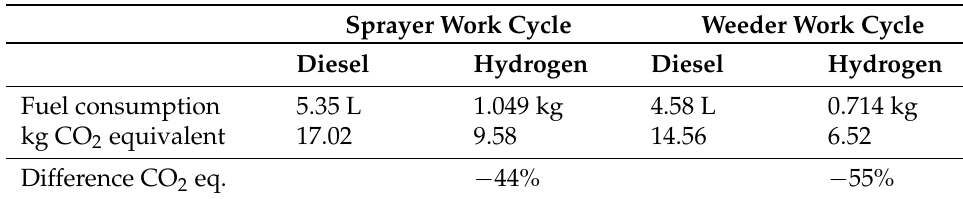
Table 6. Simulation results for the total kg of equivalent CO 2